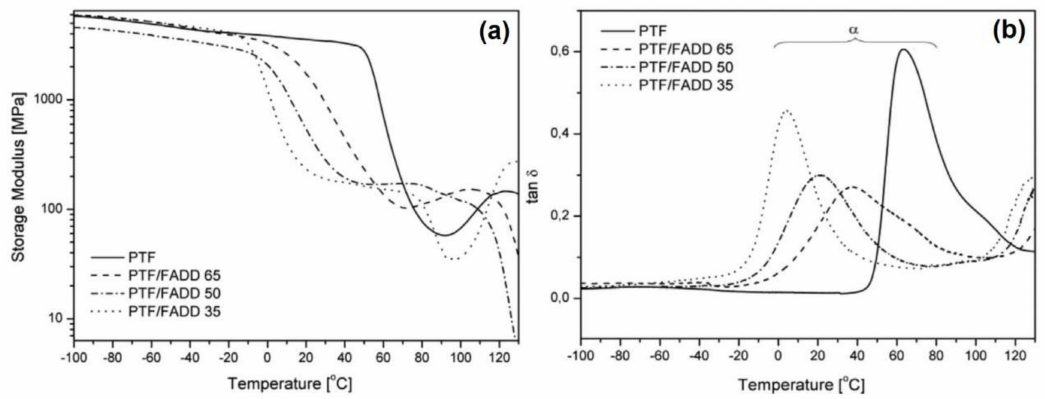
Figure 19. ( a ) Storage modulus and ( b ) tan δ graphs showing how crystallization phenomena can influence the intensity of the tan δ in PPF- co -PFADDF copolymers [58].